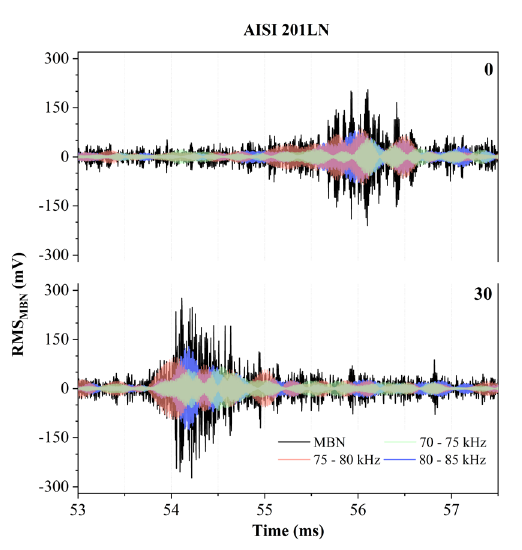
for 201LN steel. MBN